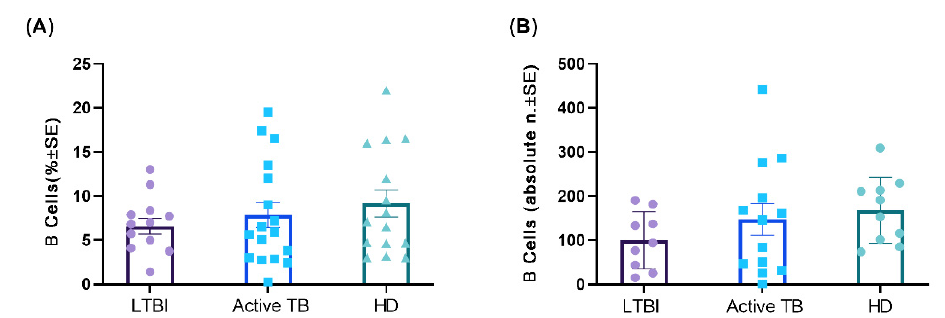
Figure 1. Quantitative analysis based on the frequency of CD19 + B cells in PBMCs ( A ) and absolute CD19 + B cell count ( B ) from peripheral blood among the groups; each dot represents one individual subject out of 13 LTBI, 17 Active TB, and 15 HD. Each horizontal bar represents the mean and the SE of each group.